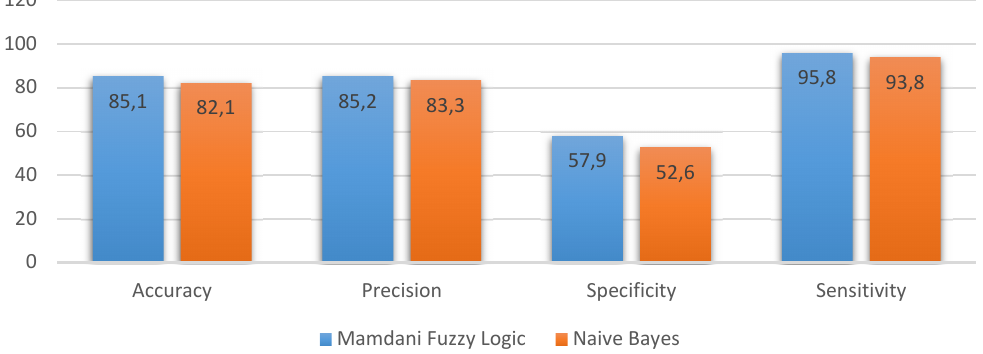
Fig. 7 Comparison of the mamdani fuzzy logic method and the naïve bayes method on dental disease